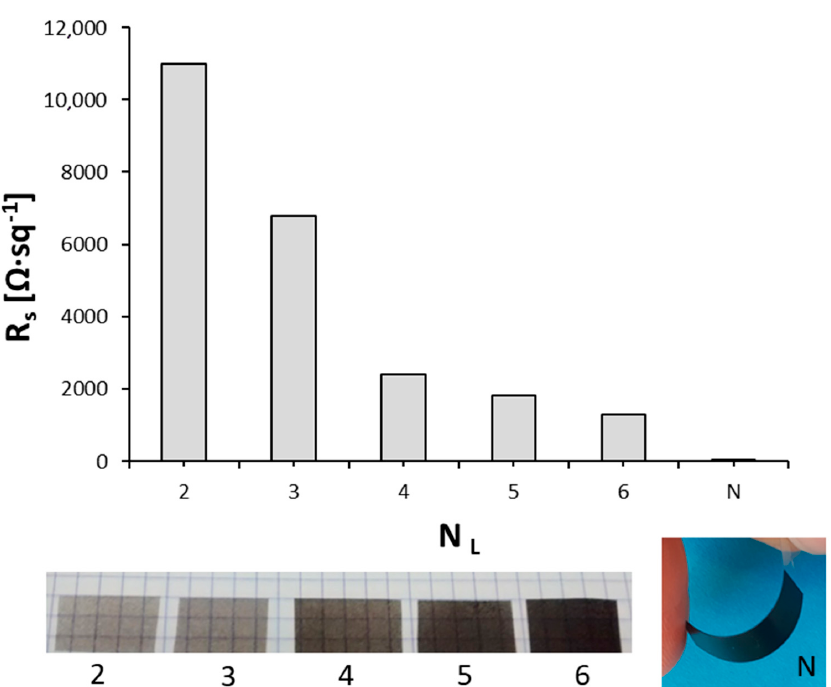
Figure 2. Sheet resistance ( R s ) of MSH-2 films with increasing number of layers ( N L ). The final electrode with a N layers had a thickness of 0.06 mm and R s of 11 Ω ·sq − 1 .